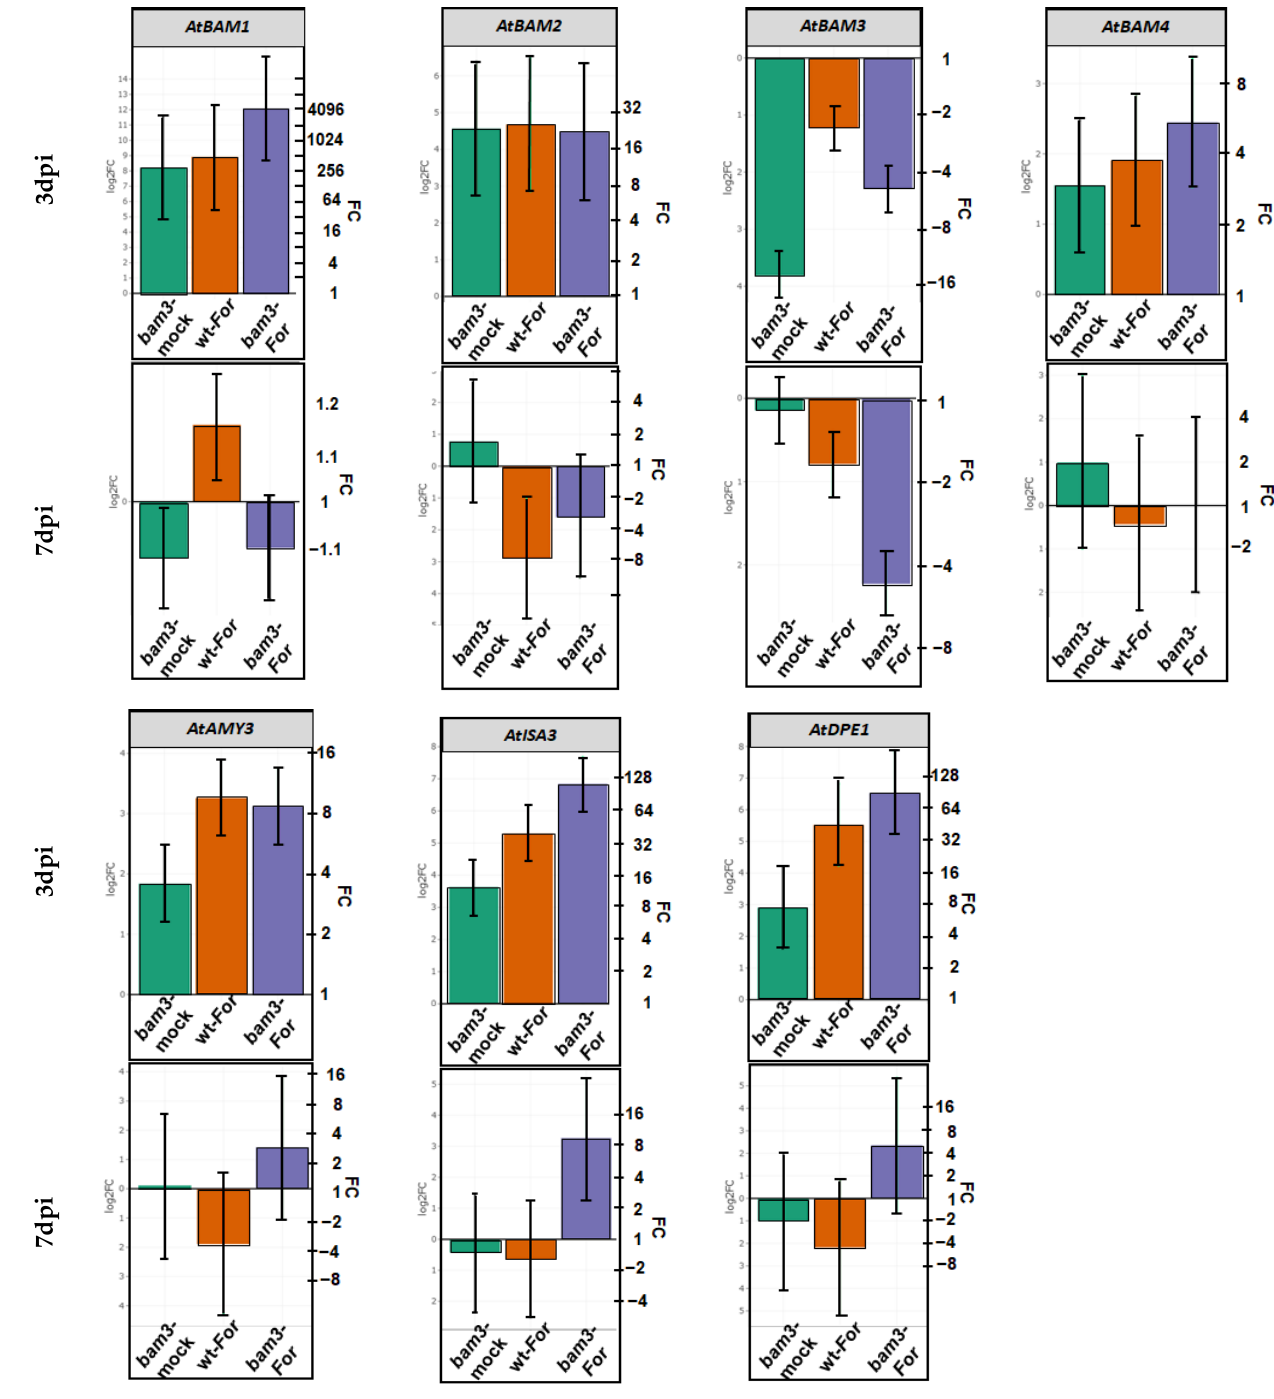
Figure 2. Comparative transcriptional analysis of BAM1 , BAM2 , BAM3 , BAM4 , AMY3 , ISA3 , and DPE1 related to starch degradation. Fold change represents the relative difference in expression between each treatment (i.e., mock bam3 plants, For -inoculated wt, and For -inoculated bam3 plants) and control (i.e., wt mock plants) (x axis) at three and seven dpi. Three independent biological replicates with two technical replicates were analyzed, and β -ACTIN2 , β -ACTIN7 , and β -ACTIN8 were used as reference genes. Bars indicate the 95% confidence interval of the estimates (2*SE) in all panels. Statistical analysis was performed with linear mixed models. Estimates for which the confidence interval includes the baseline value 0 (1 in fold-change scale) are not significantly different from the control at α =